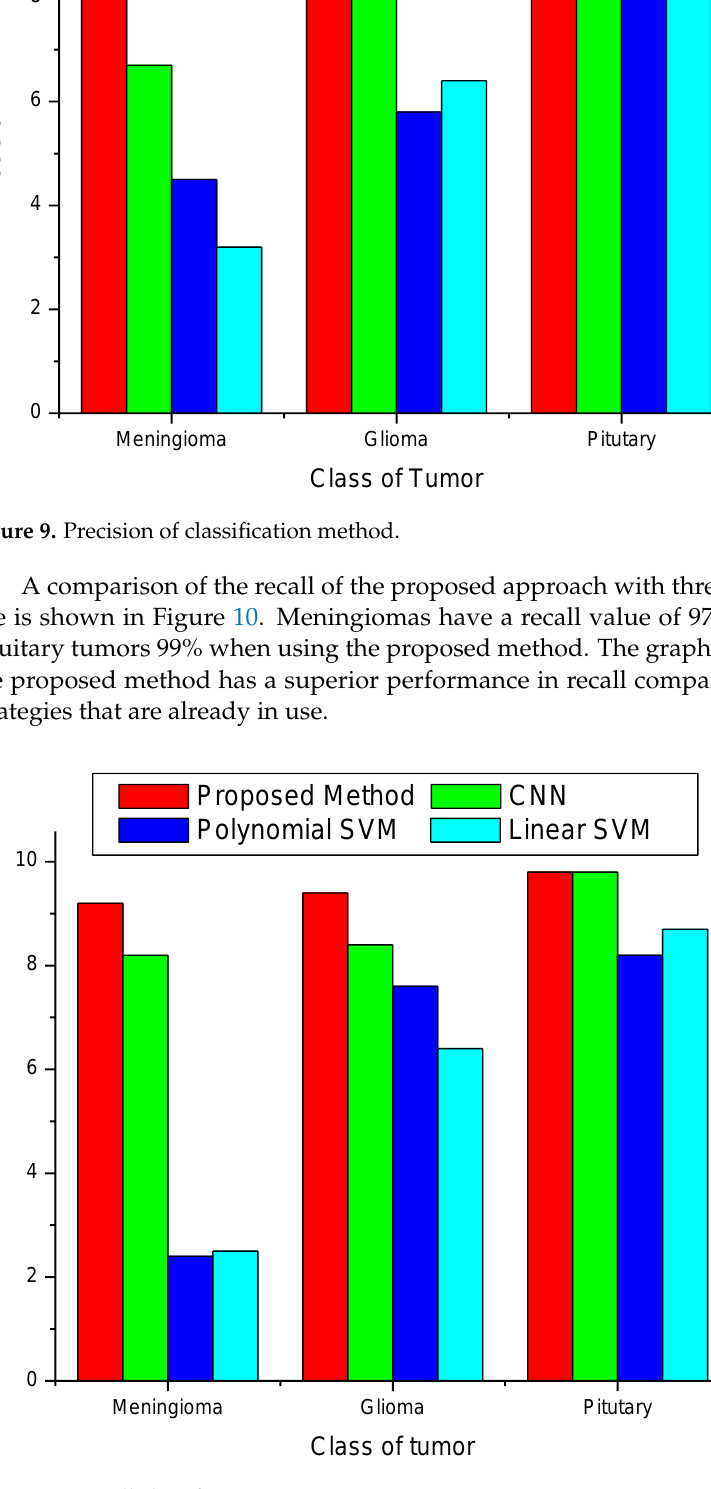
Figure 10. Recall classification.